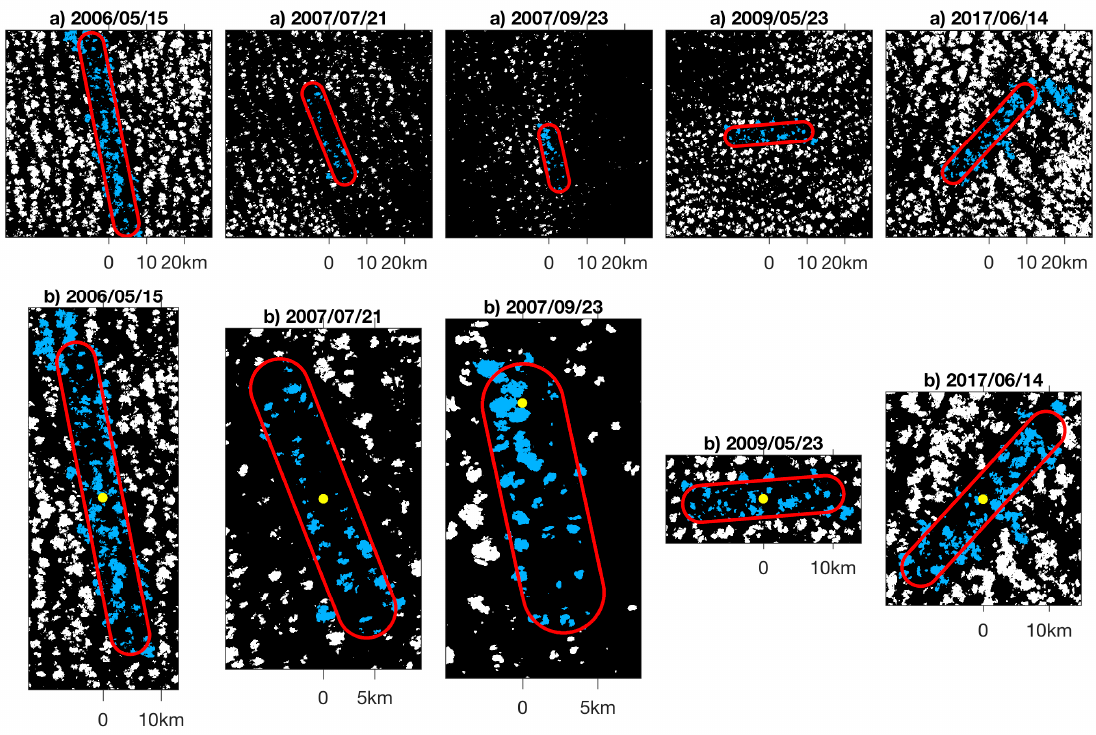
Figure 4. Landsat cloud mask for selected 5 days; Landsat cloud area obtained from the entirety of blue-tinted clouds, whereas simulated TSI-like cloud area (Section 4) is obtained from clouds strictly within the red outline subarea with variable dimensions (Table 1). ( a ) 50 km × 50 km region showing different spatial patterns of cloud cover and ( b ) zoomed in to red outline subarea observed by a theoretical TSI operating with a 130° FOV for 1 h on all days except 2007/09/23 for 30 min due to sun glare contamination. North is up and East is to the right. SGP site is indicated as yellow dot at the origin. The selected days represent a wide range of cloud fraction (0.04–0.33, see Table 1) and different spatial patterns of cloud cover.